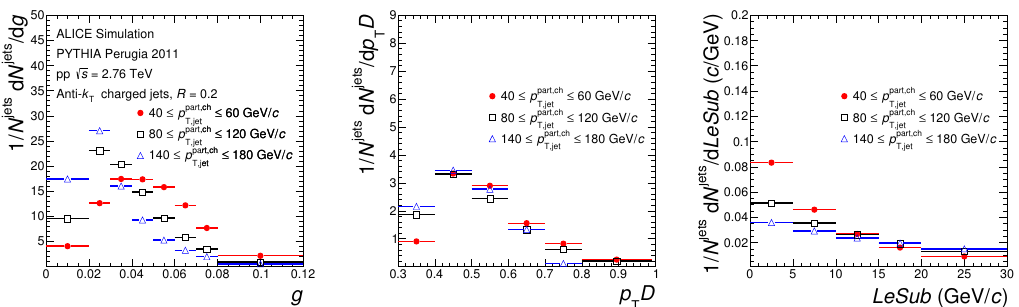
Figure 2 . g , p T D , and LeSub as obtained from PYTHIA Perugia 2011 simulations of pp collisions p at s = 2 : 76 TeV for three di(cid:11)erent transverse momentum intervals. was also used to enhance the fraction of the 10% most-central Pb-Pb collisions. The online centrality selection has an e(cid:14)ciency of 100% for the 0{7% interval in centrality percentile and drops to about 80% e(cid:14)ciency for the 7{10%